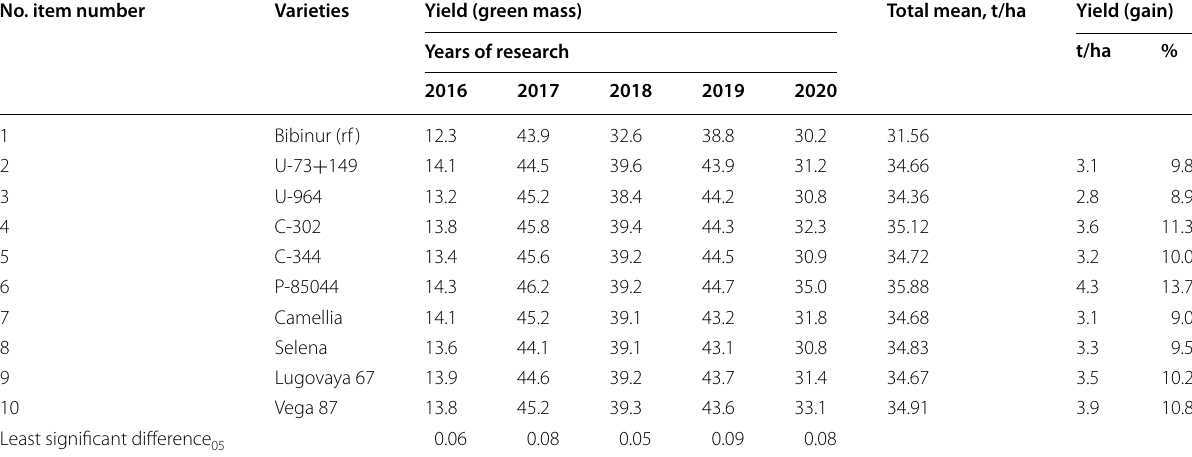
Table 2 The green mass yields of alfalfa varieties, t/ha No. item number